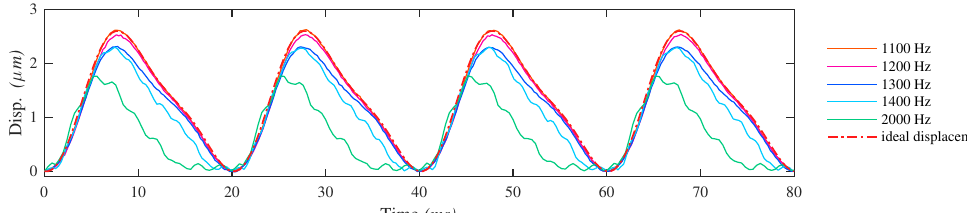
Figure 10. Distortion of the input displacements with the LHW signals at different driving frequencies. The voltage amplitude is 2.3 V. All the time vectors of the displacements at different frequencies have been remapped to a same frequency ( f * = 50 Hz) for better distortion comparison.